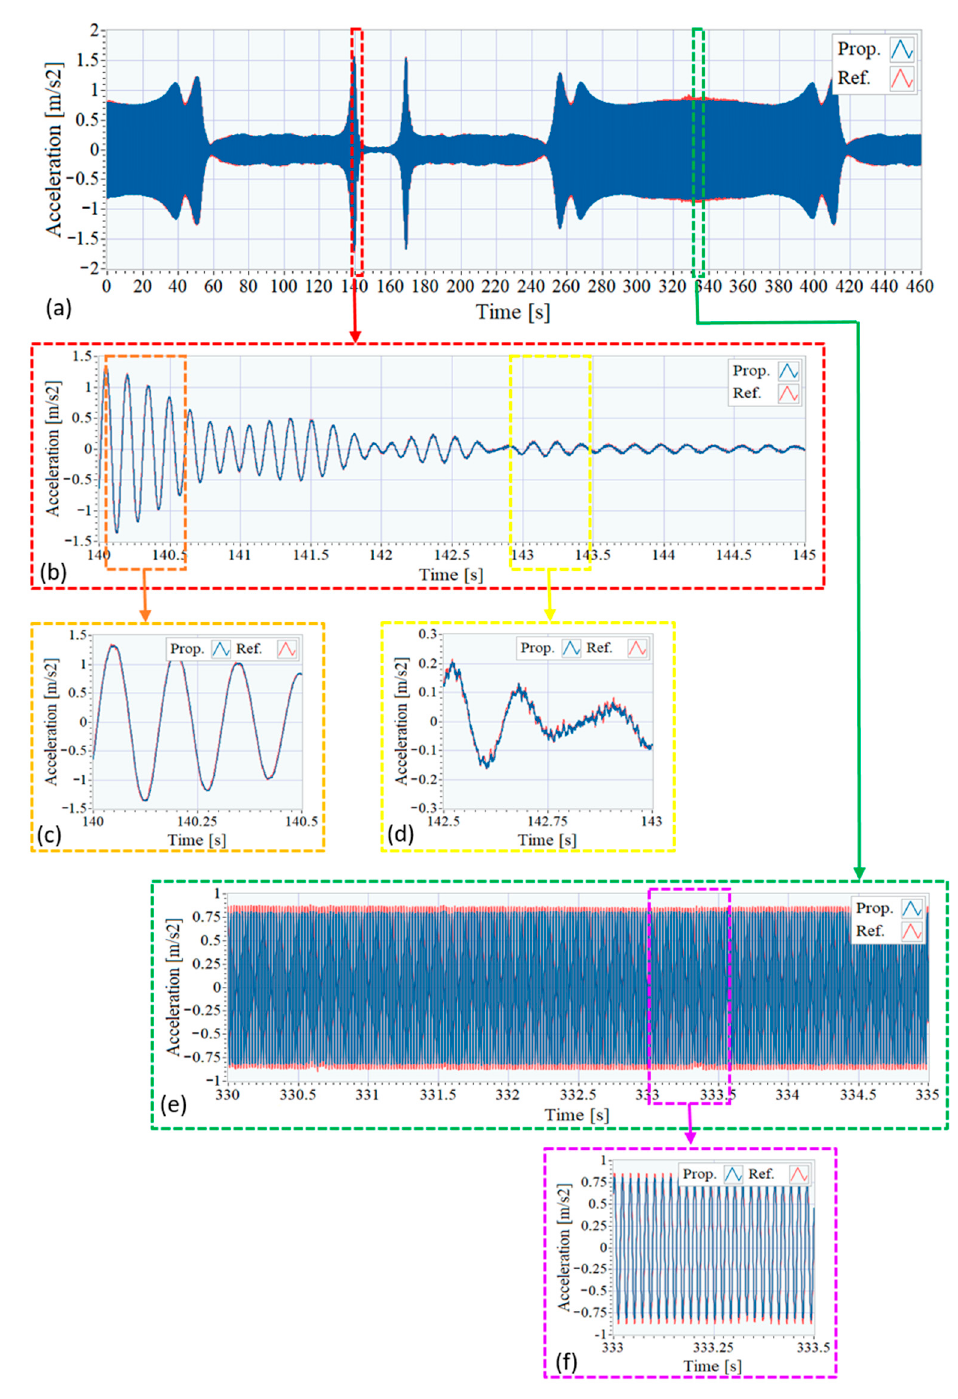
Figure 9. Time signals of accelerometers at position E4. ( a ) Full signal. ( b ) Zoom between 140 and 145 s. ( c ) Zoom between 140 and 140.5 s. ( d ) Zoom between 142.5 and 143 s. ( e ) Zoom between 330 and 335 s. ( f ) Zoom between 333 and 333.5 s.